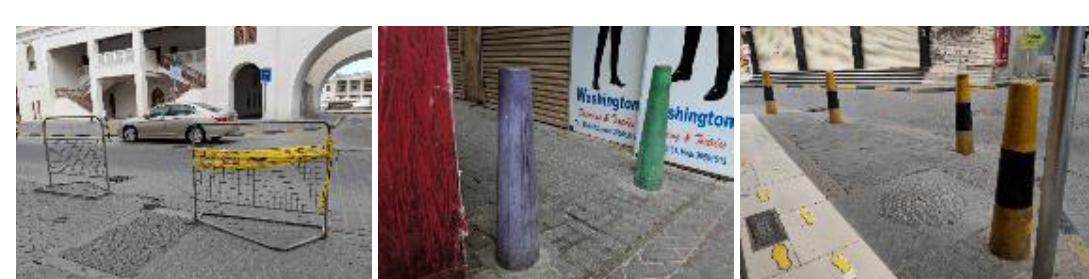
Figure 15. Fences and Barriers are not matching with the traditional style of